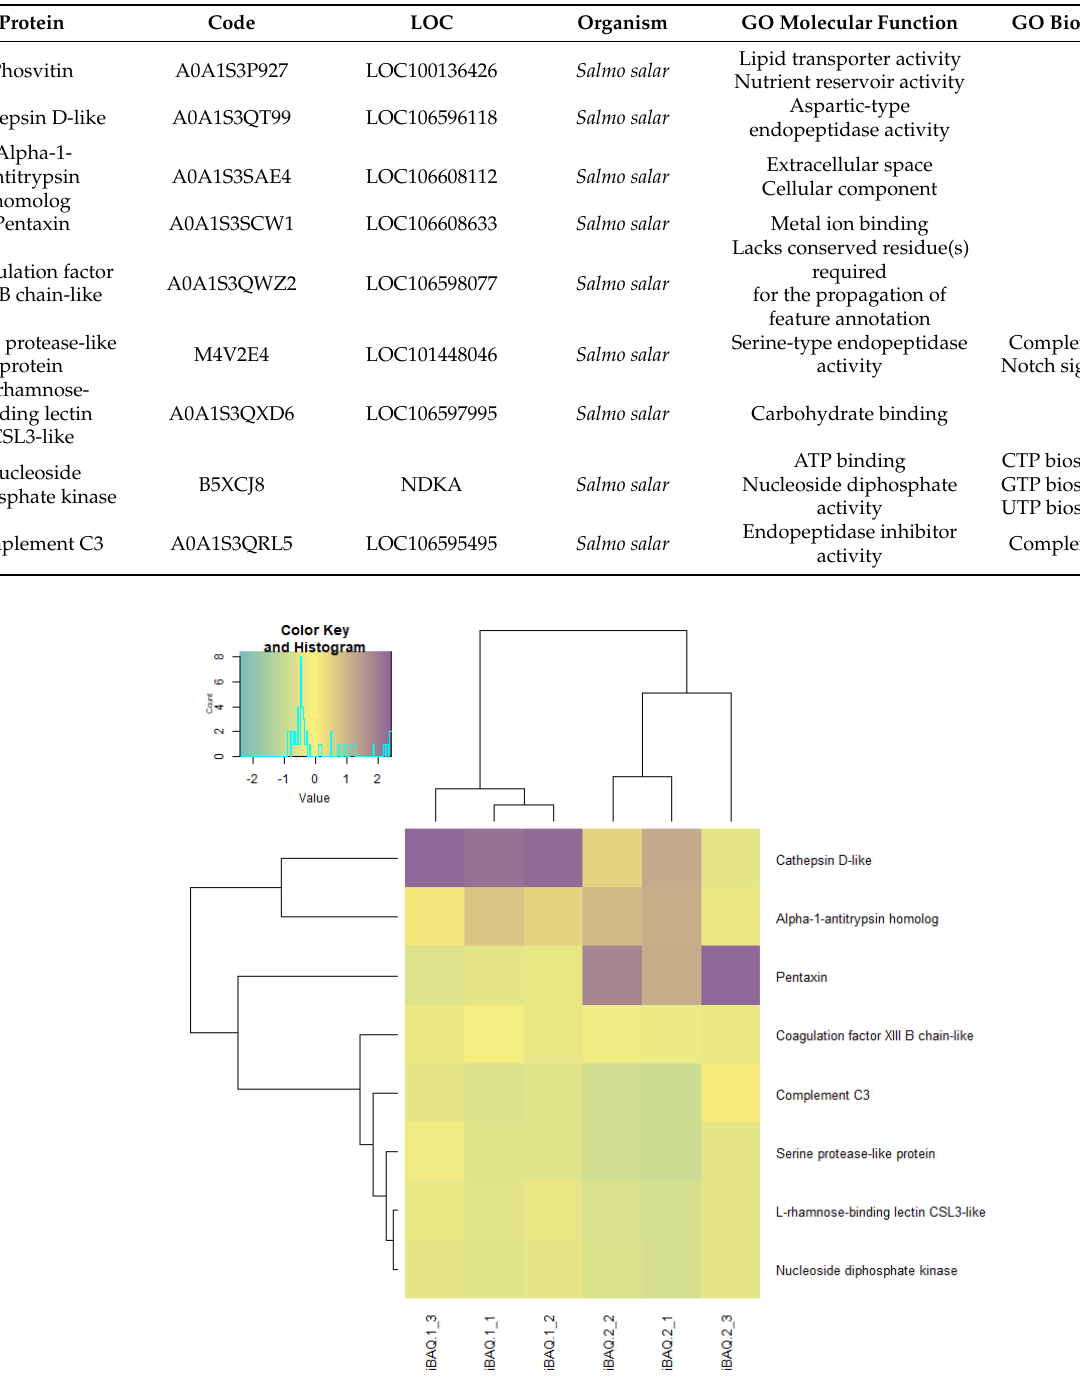
Figure 9. Heatmap for 9 selected proteins of Atlantic salmon eggs ( Salmo salar L.) for the control and experimental groups. Note: Phosvitin has been removed from the graph to exclude high noise levels. IBAQ1_X — control group, iBAQ2_X — experimental group, where X is an ordinal number. Quantities are presented in gradient format (legend top left). The upper dendrogram is the cluster analysis for the experimental group, the left dendrogram is for the identified proteins.